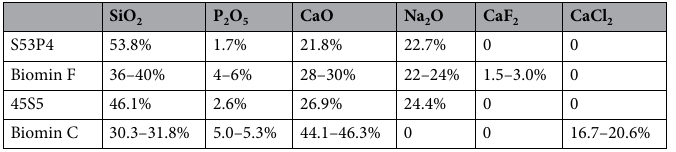
Table 1. Composition of glass used in this study to prepare a 10% mixture, according to the information provided by the